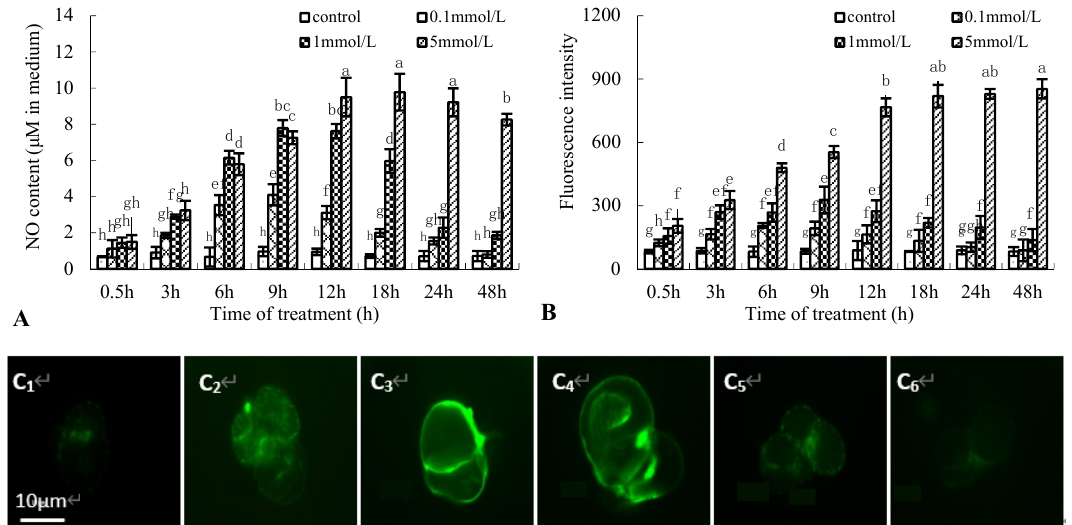
Figure 2. E ff ect of Put on nitric oxide (NO) generation in suspension cells of birch. ( A ), NO content in culture medium of birch; ( B ), NO fluorescence intensity in suspension cells of birch; ( C ), NO fluorescence intensity in suspension cells after 1 mmol · L − 1 Put treatment ( C 1 , Control; C 2 , 3 h after Put treatment; C 3 , 9 h after Put treatment; C 4 , 12 h after Put treatment; C 5 , 24 h after Put treatment; C 6 , 48 h after Put treatment).